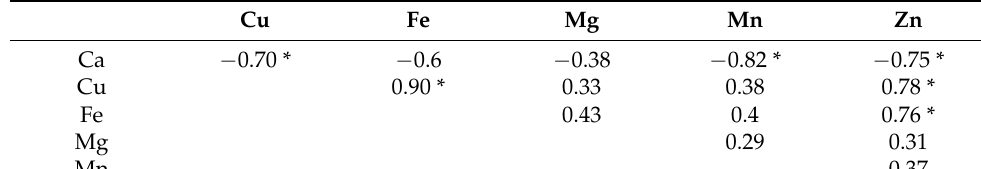
Table 2. The values of the correlation coefficients for the content of analytes in the tissue of women. Statistically significant values are marked with an asterisk.